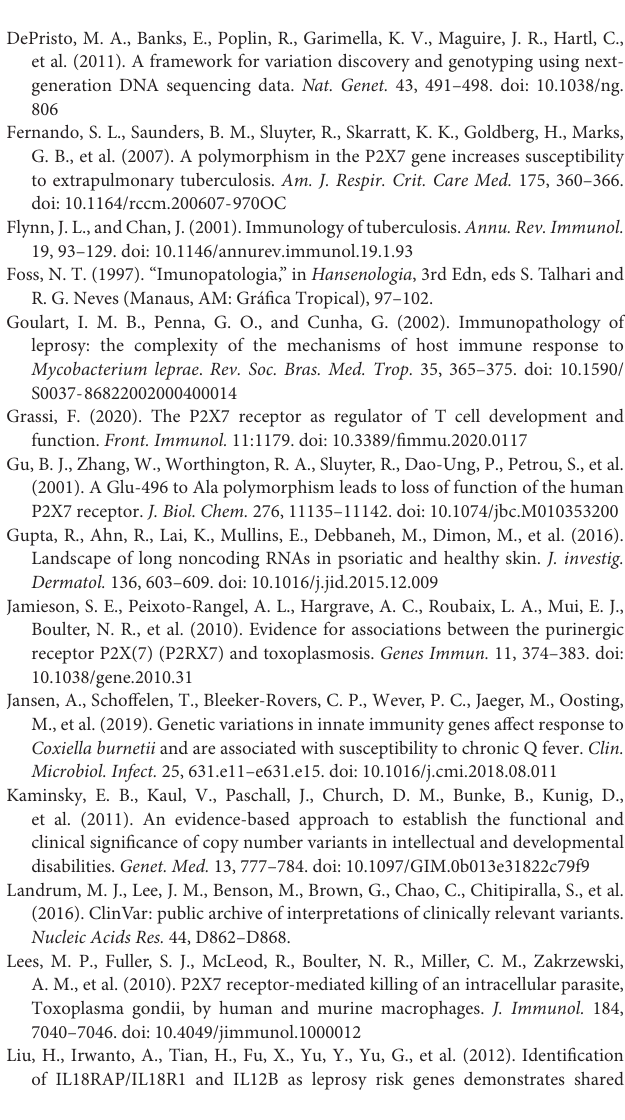
Supplementary Table 4 | Differentially expressed genes. Supplementary Table 5 | Functional Analysis of Gene Ontology for DEG genes. Supplementary Table 6 | SNPs for P2RX7. Supplementary Table 7 | Clinical variant information. Supplementary Dataset 1 |